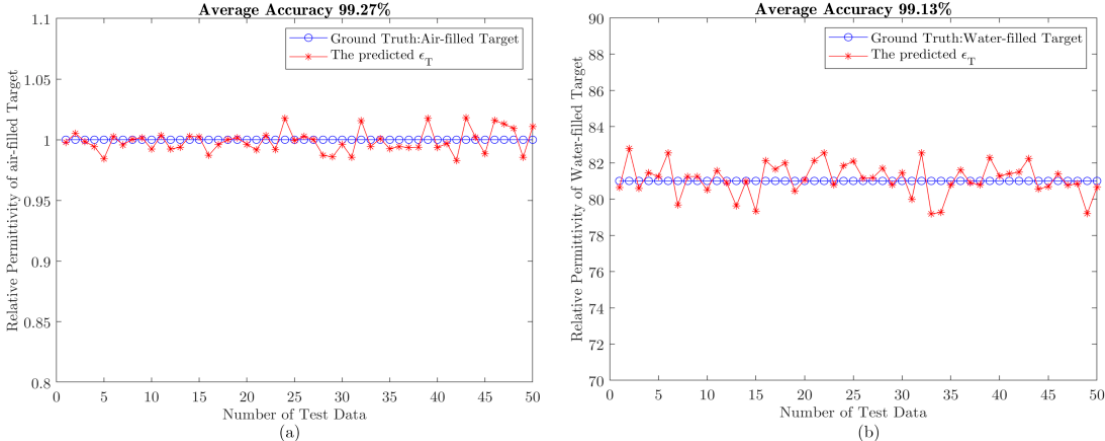
Figure 10. Results of estimating ε T in single-layer media. ( a ) Air-filled target; ( b ) water-filled